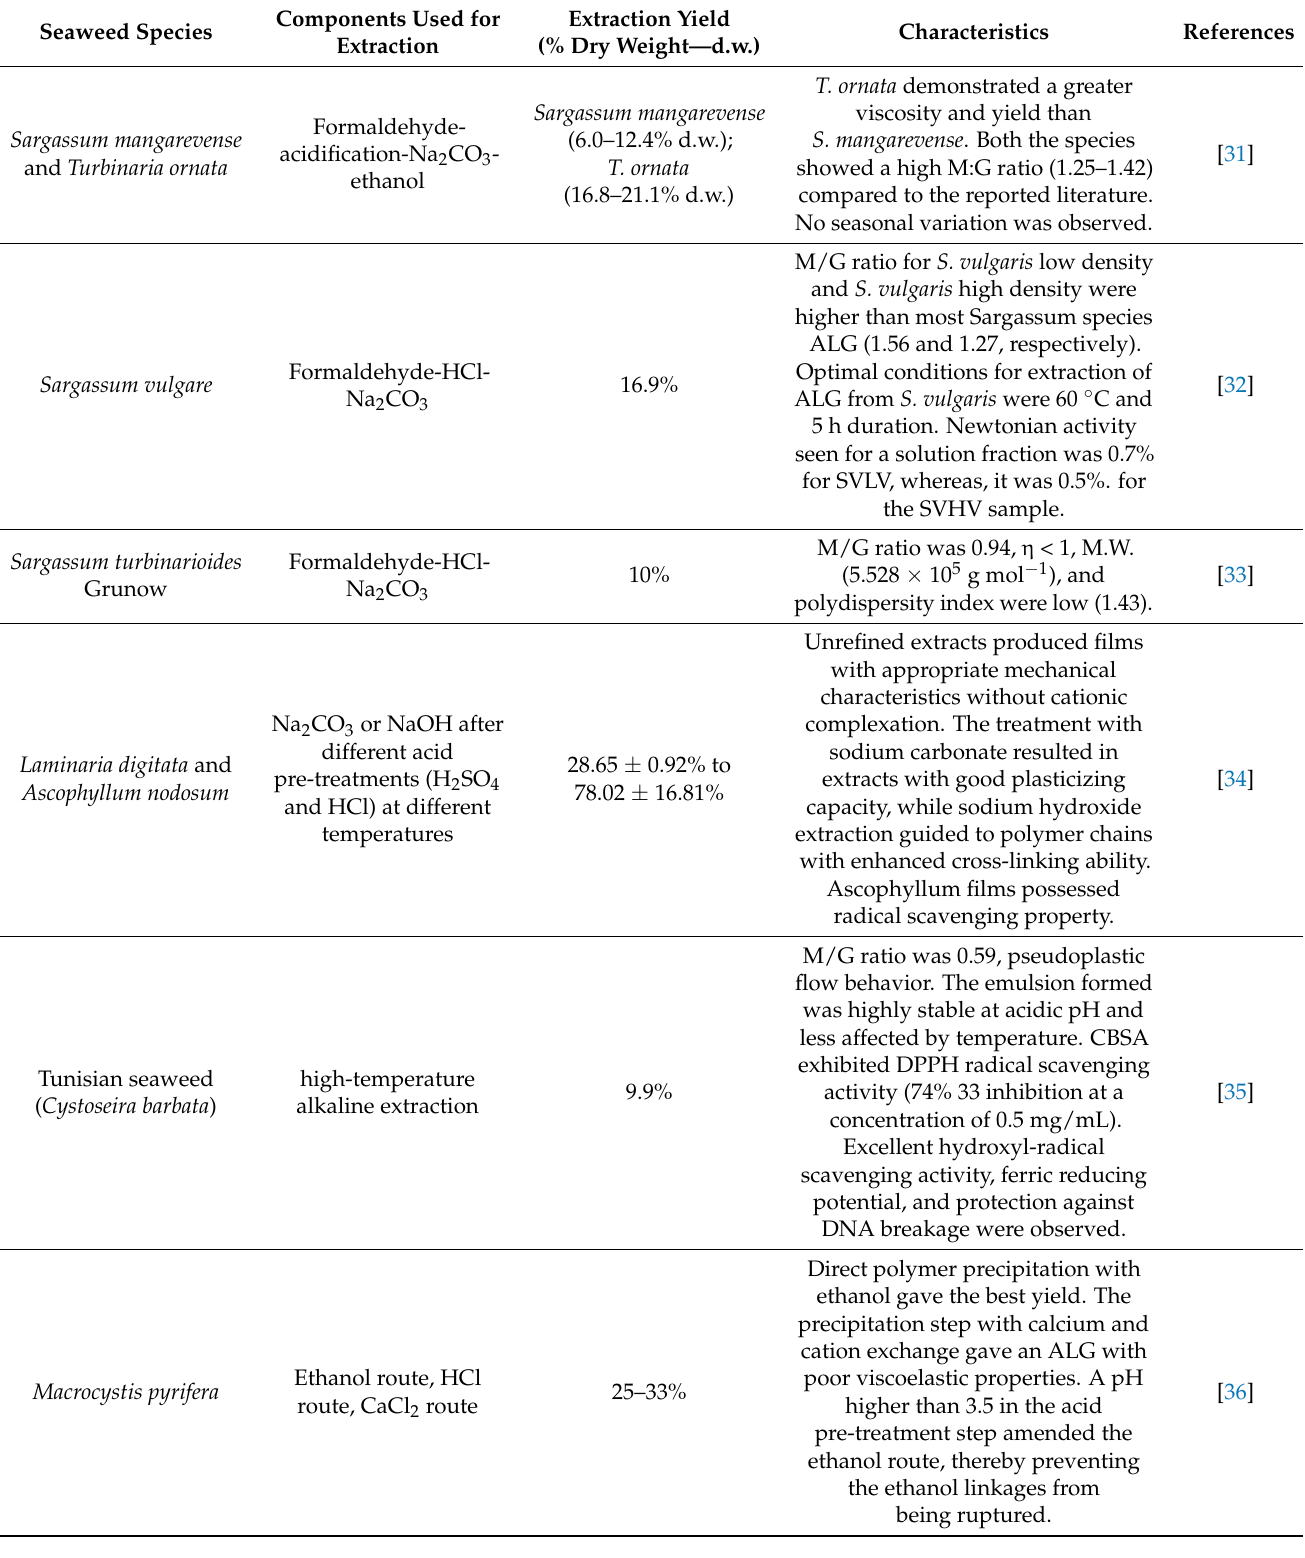
Table 1. Various methods for the extraction of